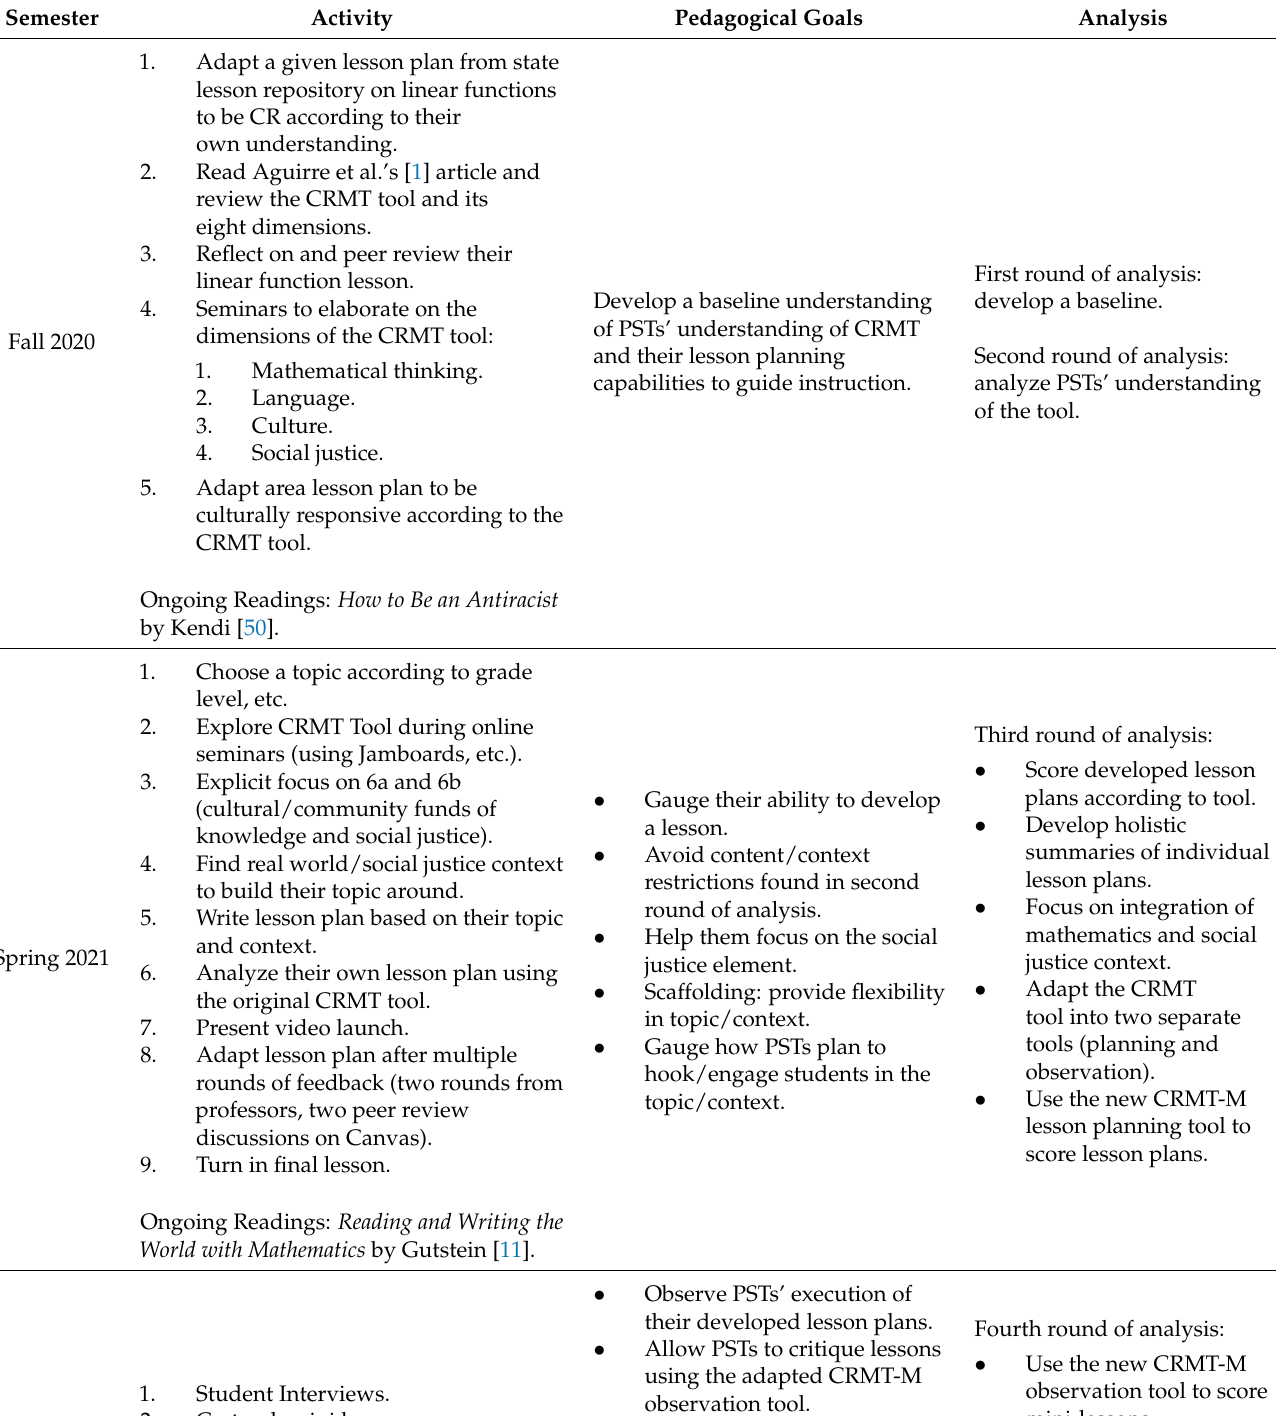
Table 1. Seminar